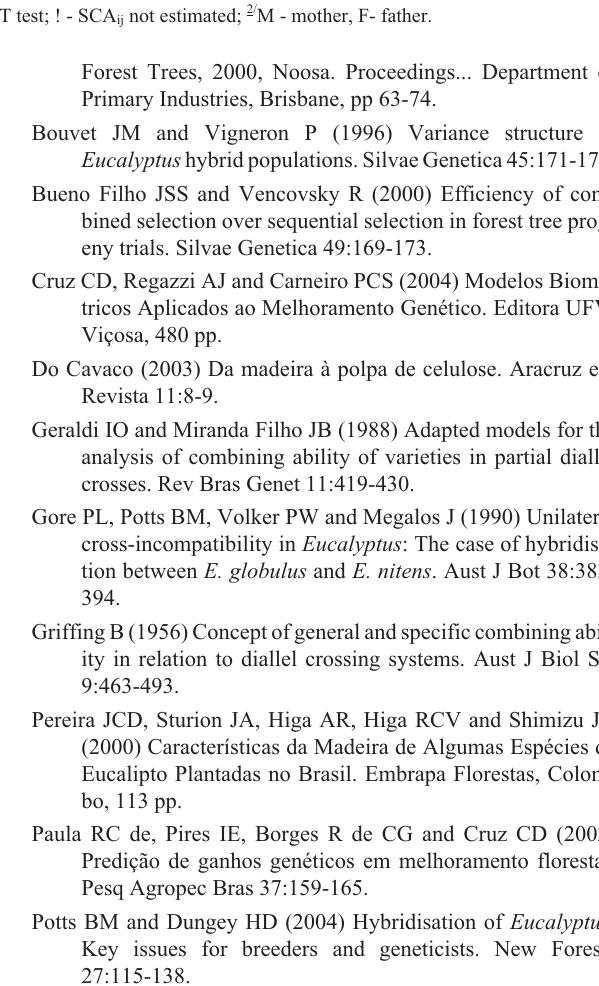
Table 5 - Estimate of the effects of the general combining ability of group 1 (GCA ability (SCA ij ), for the circumference at breast height (CBH) and wood density (WD) obtained in the evaluation of two-year-old trees from diallel crossings of E. globulus clones (fathers) and elite clones (mothers) in the joint analysis.